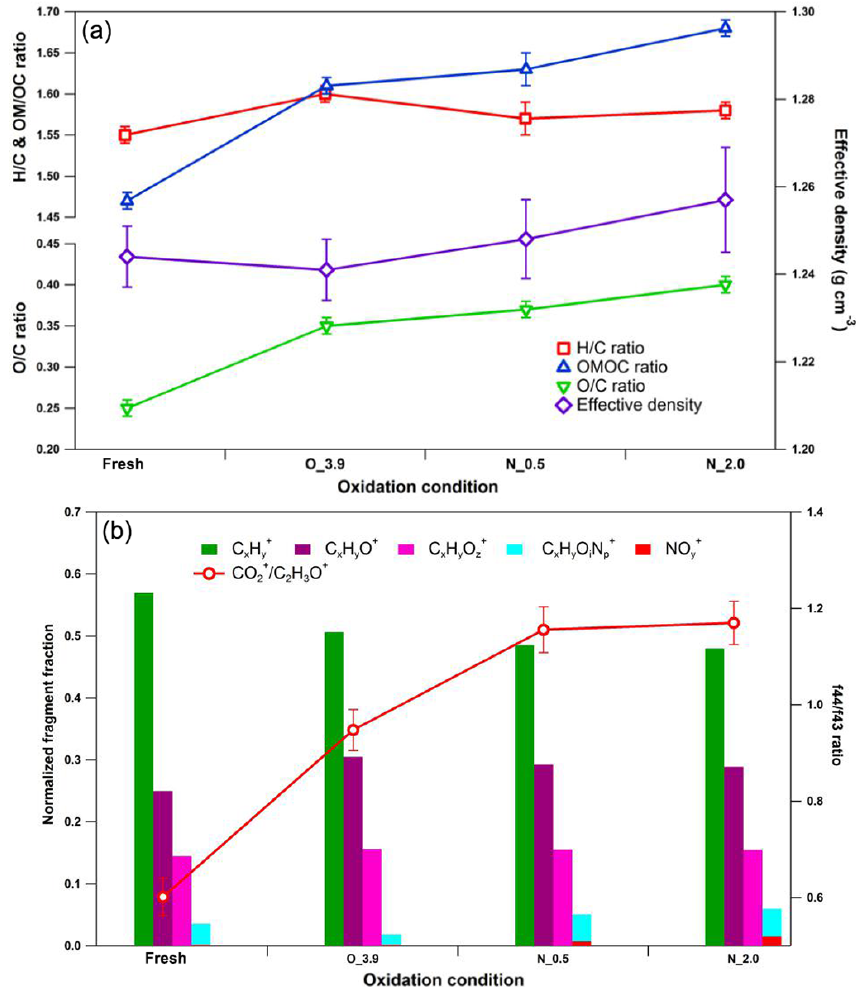
Figure 8. Dynamic changes for chemical characteristics of tar ball aerosols under NO x -dependent OH photochemical oxida- tion: (a) OM / OC, O:C, H:C, and particle density changes; (b) mass spectra changes with different oxidation conditions in terms of C x H + y , C x H y O + , C x H y O + z , and C x H y O z N + p fragment groups. C x H y O z N + p include all nitrogen-containing fragments (e.g., C x H y ON + , C x H y O z N + , and C x H y N + ); NO + y include NO + and NO + . O_3.9 represents 3.9 days’ equivalent atmospheric photochemical aging in the i 2 absence of NO x ; N_0.5 and N_2.0 indicate photochemical oxidation with 0.5%vol and 2.0%vol N 2 O addition at ∼ 4 . 0 days’ atmospheric